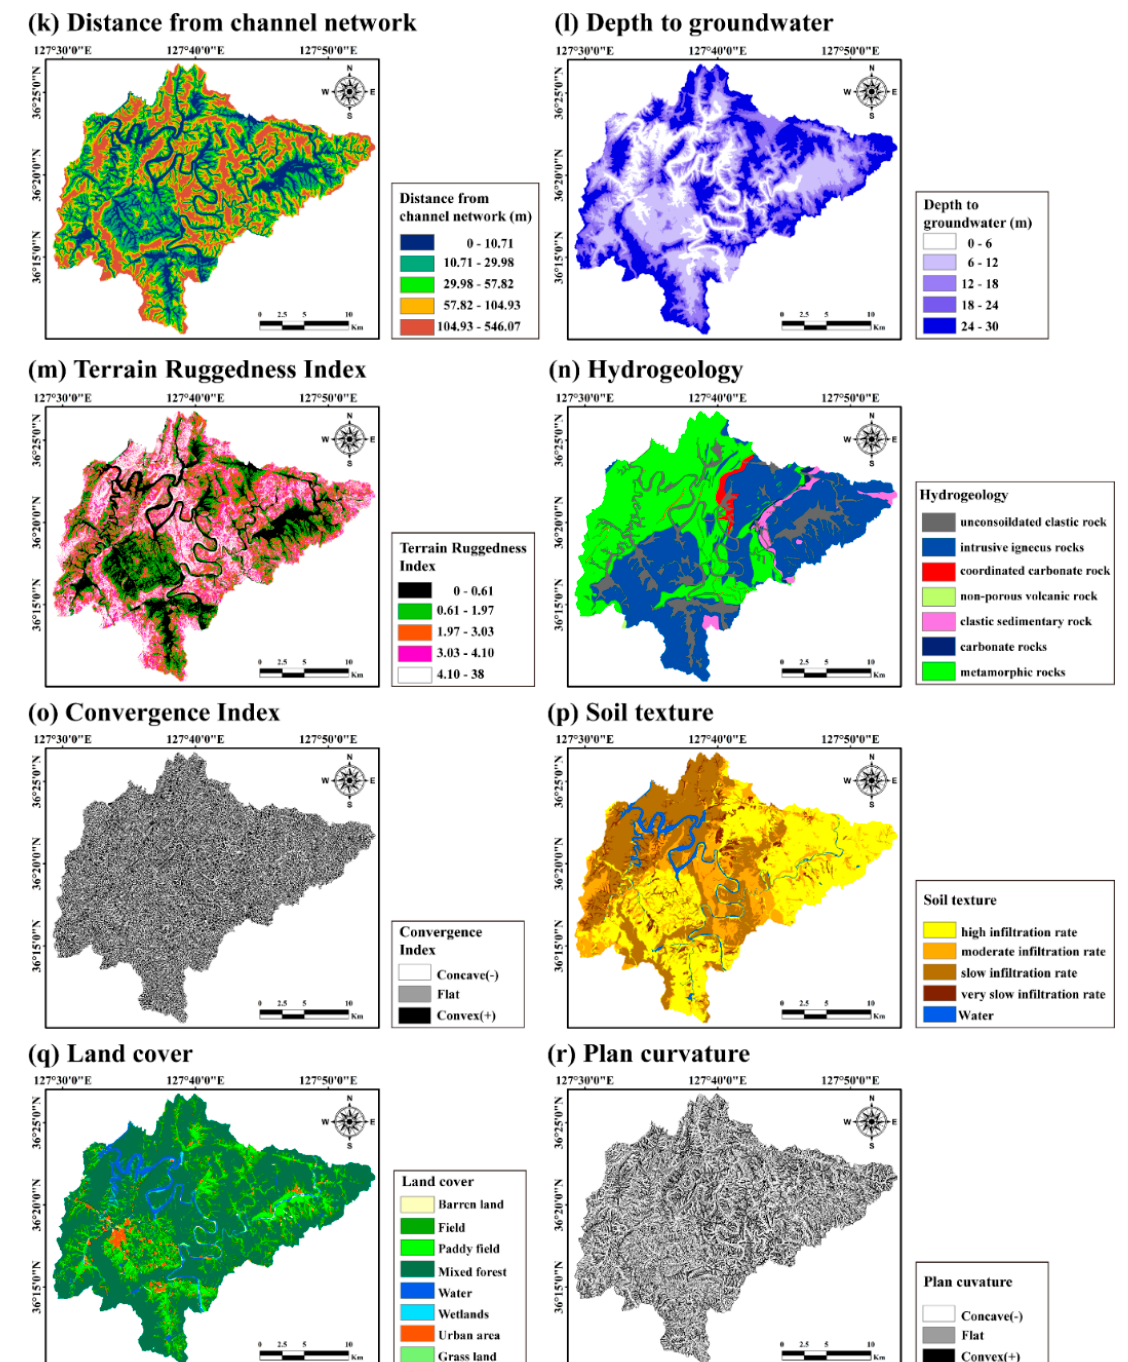
Figure 2. The spatial database constructed for Groundwater Productivity Potential (GPP). ( a ) slope gradient, ( b ) hydraulic slope, ( c ) relative slope position, ( d ) valley depth, ( e ) Topographic Wetness Index (TWI), ( f ) Slope length (LS) factor, ( g ) drainage basin, ( h ) distance from lineament, ( i ) lineament density, ( j ) distance from fault depth (continue). ( k ) distance from channel network, ( l ) depth of groundwater, ( m ) Terrain Ruggedness Index (TRI), ( n ) Hydrogeology, ( o ) convergence index, ( p ) soil texture, ( q ) land cover, ( r ) plan curvature.